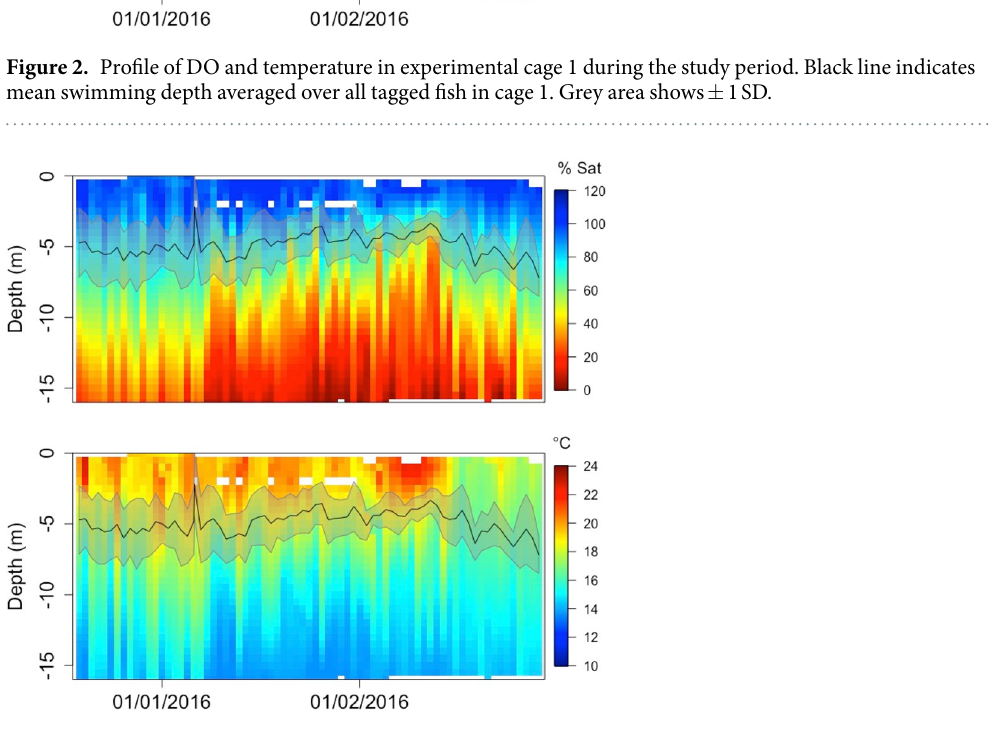
Figure 3. Profile of DO and temperature in experimental cage 2 during the study period. Black line indicates mean swimming depth averaged over all tagged fish in cage 2. Grey area shows ± 1